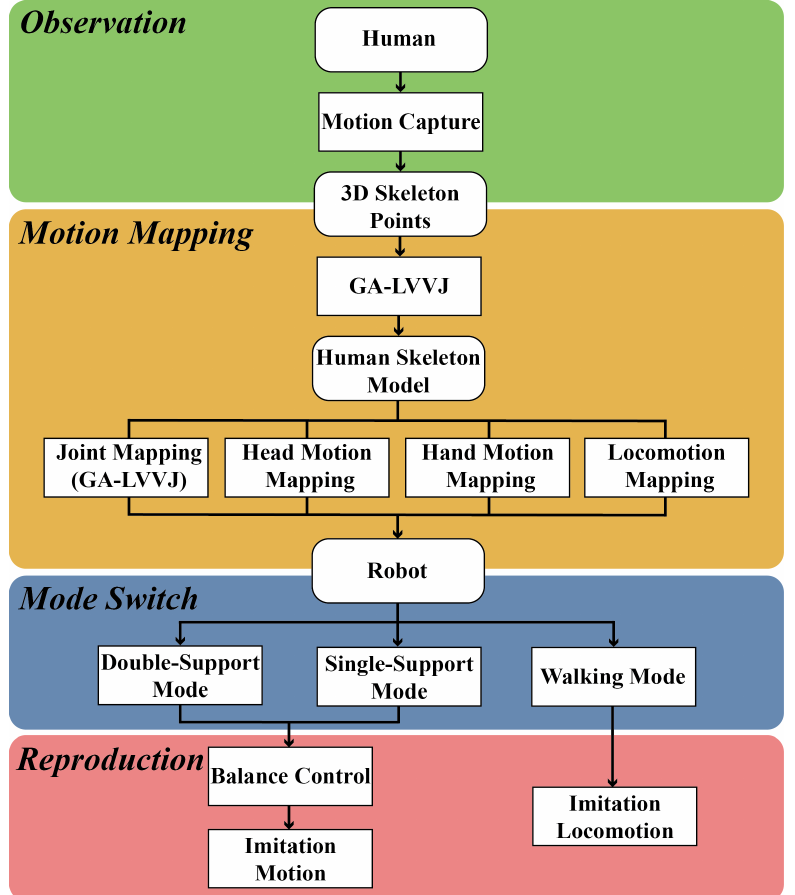
Figure 1. The framework of the proposed whole-body imitation